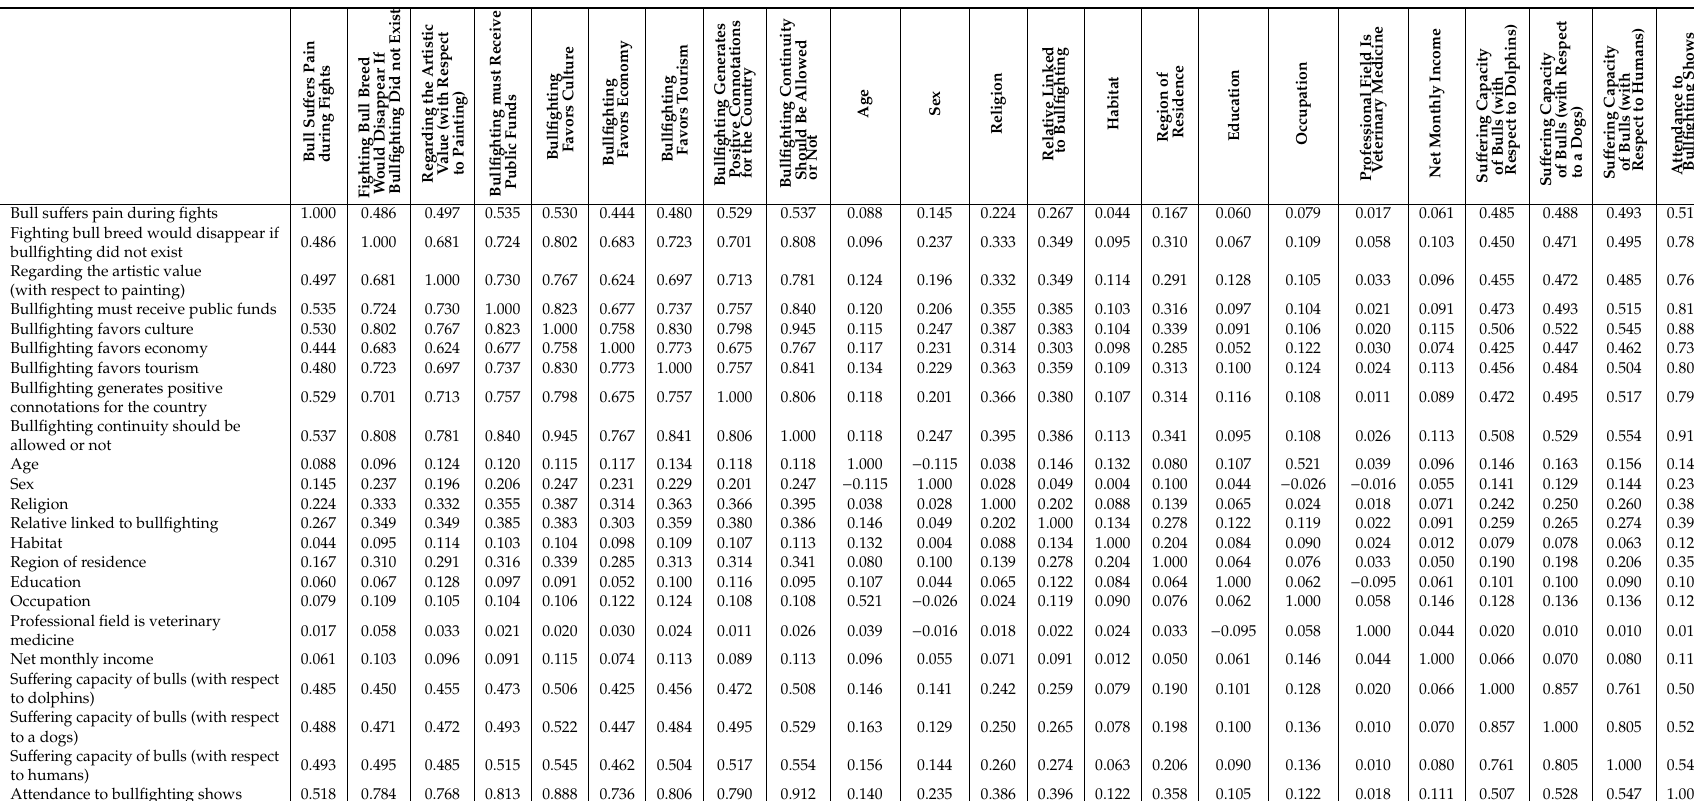
Table A1. Correlation matrix of the transformed variables (after optimal scaling) on demographic and bullfighting opinions in